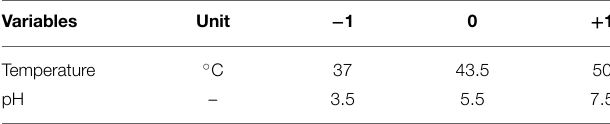
TABLE 2 | Coded values for each variable of FCCD for